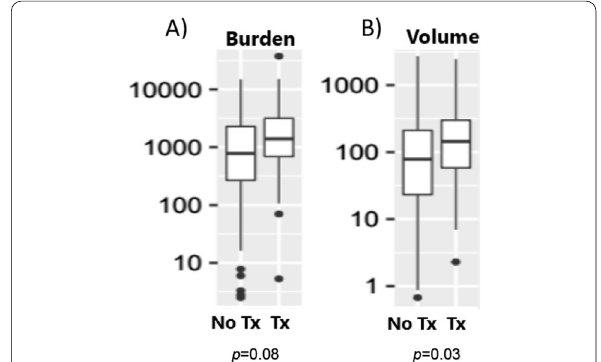
Fig. 2 Box Plot of tumor PET CT characteristics in steroid naïve (no Tx) and steroid‑treated (Tx) patients. The numbers of the Y axis are presented in Log scale, A tumor burden B tumor volume (cm 3